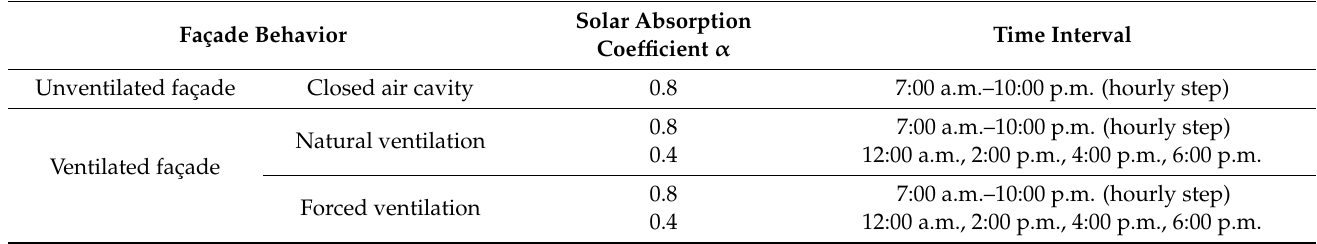
Table 2. Summary of the CFD simulations